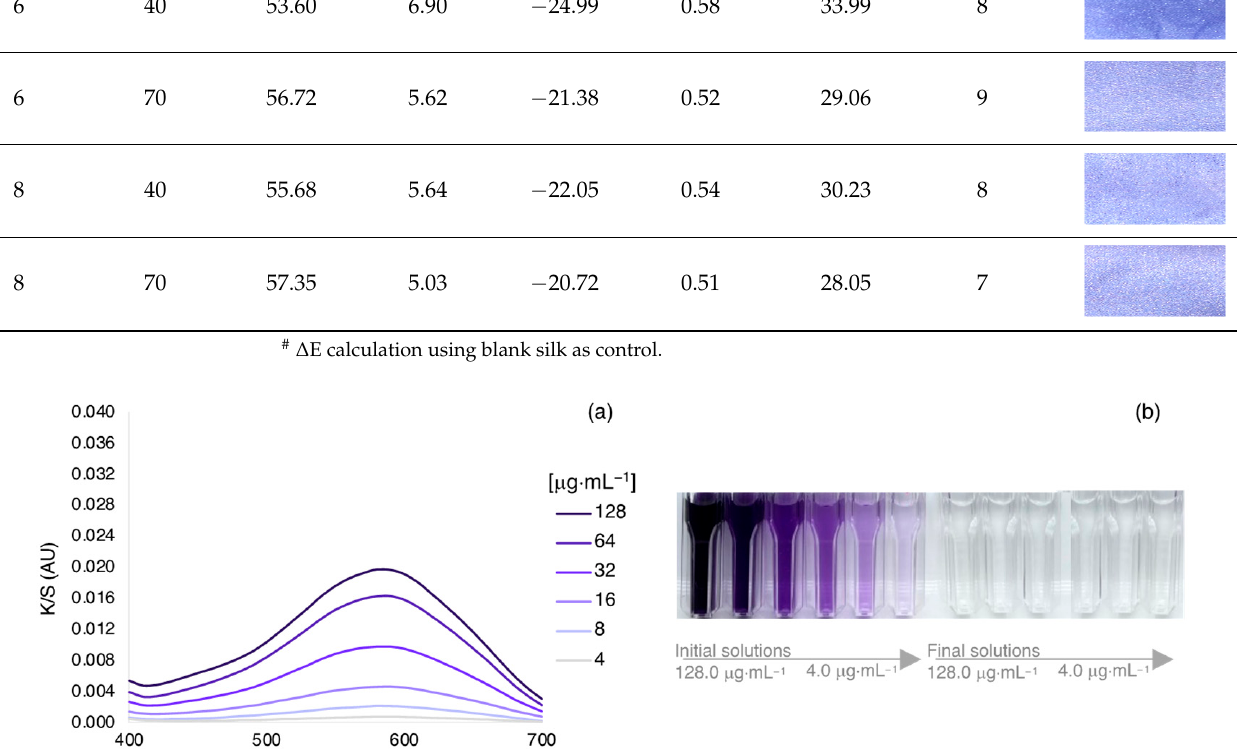
Table 4. Color coordinates (L*–lightness, a*–yellowness/blueness, and b*–redness/greenness), K/S, ∆ E, and UPF of the samples functionalized with AzoIz.Pip under the different conditions tested. Sample pH T (°C) L* a* b* K/S sum ∆ E # UPF SK - 76.1